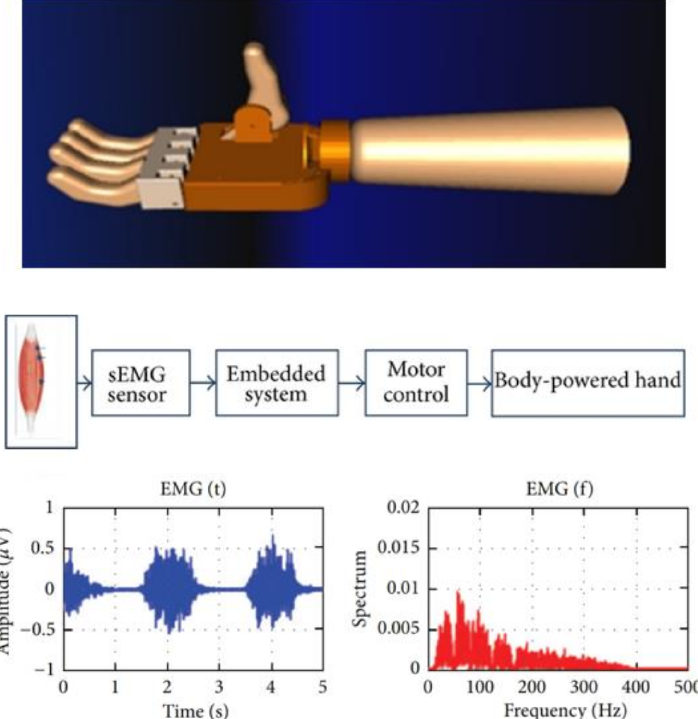
Figure 1. Myoelectrically controlled hand prosthesis designed in computer software, a design to collect the electromyography (EMG) signals, and sample generated signals [14].